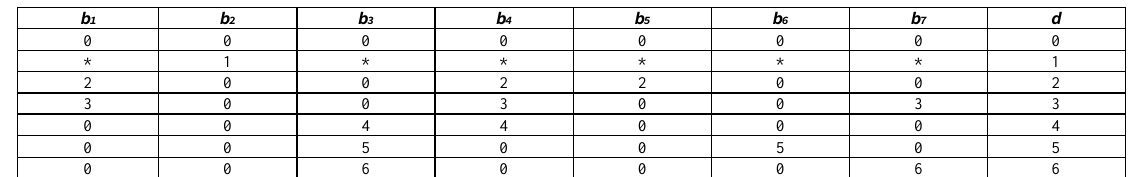
Table 2. A consistent incomplete